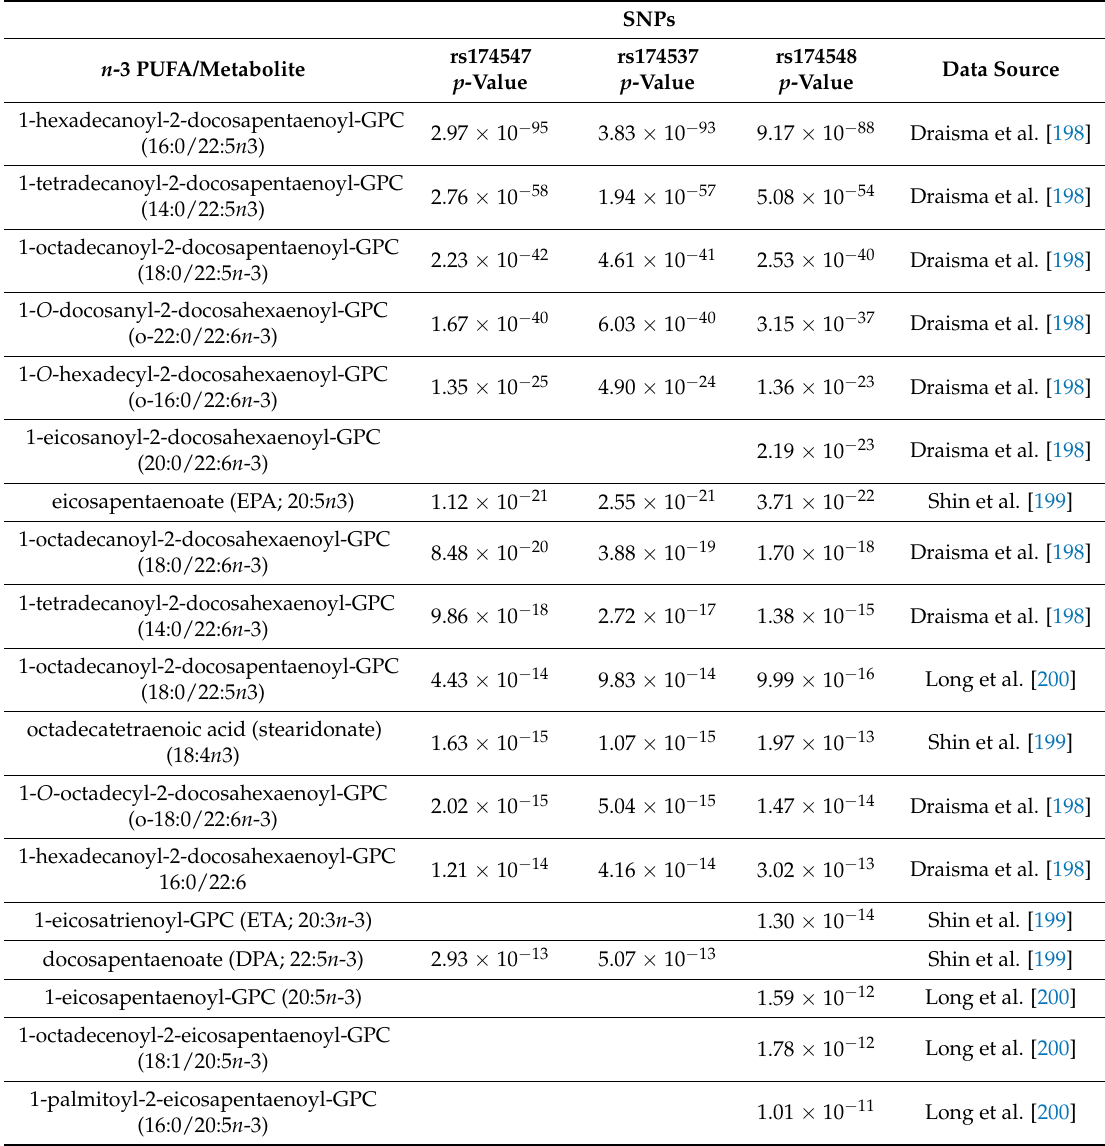
Table 1. Association of key FADS SNPS with serum LC-PUFAs.